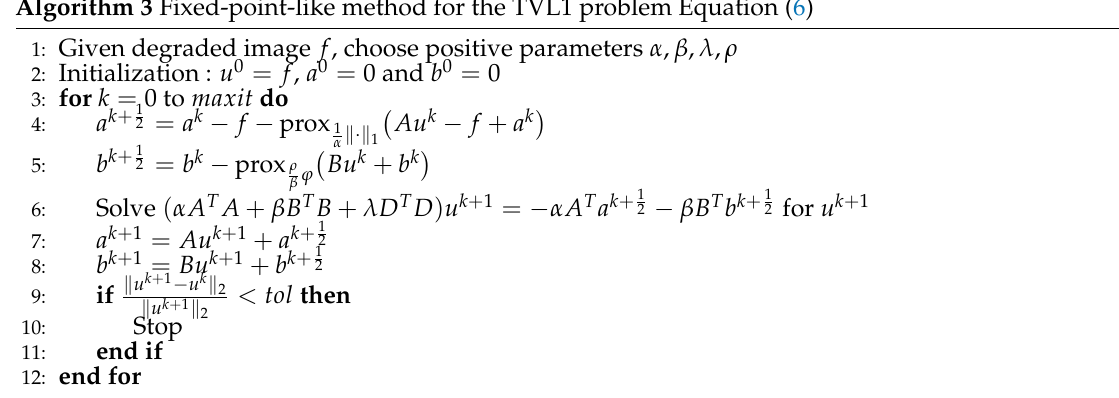
Algorithm 3 Fixed-point-like method for the TVL1 problem Equation